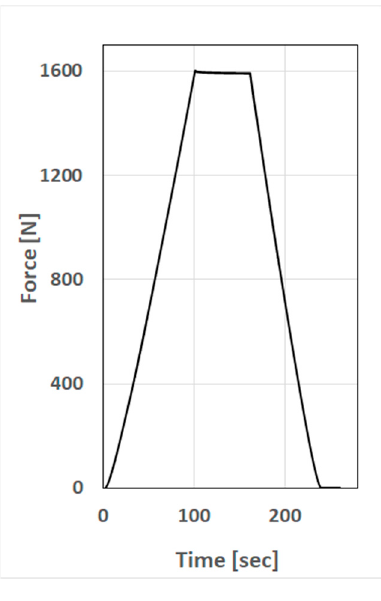
Figure 4. Indentation test: ( a ) indentation load vs. time; ( b ) projected intended area.